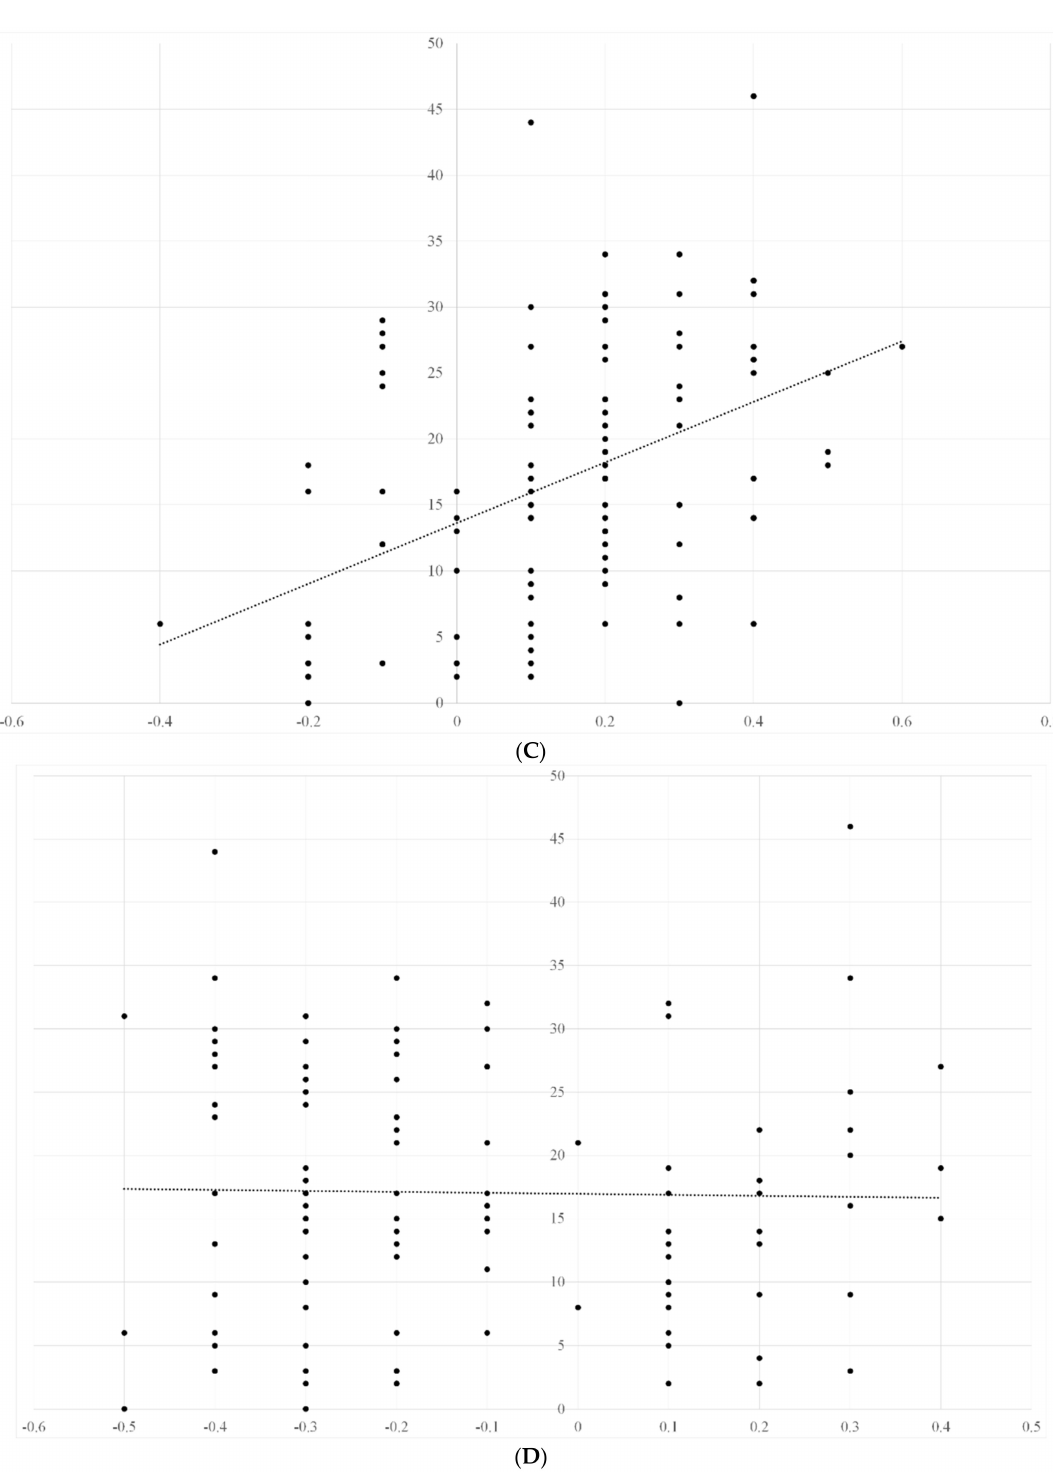
Figure 3. ( A ) Relationship between changes in nutritional status and ADL recovery in female patients; ( B ) relationship between changes in muscle strength and ADL recovery in female patients; ( C ) rela- tionship between changes in muscle quality and ADL recovery in female patients; ( D ) relationship between changes in SMI and ADL recovery in female